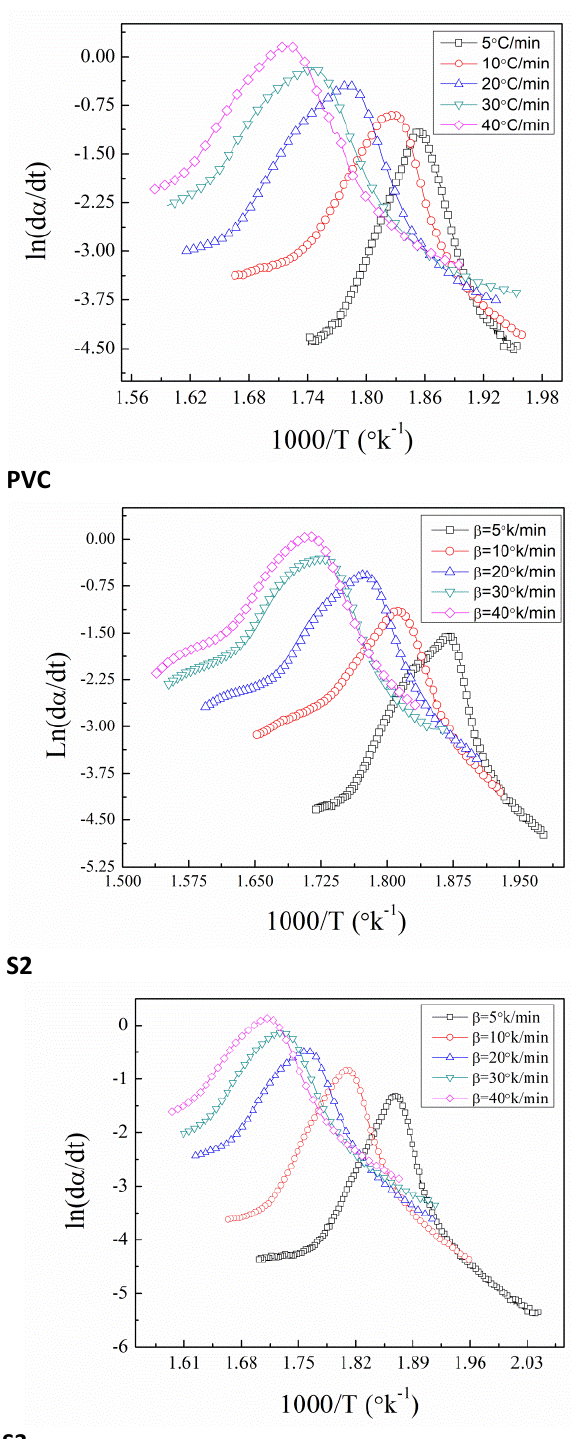
Figure 10: Variation of ln(d α /dt) with 1000/T during first decomposi- tion stage for pure PVC and PVC/MWCNTs nanocomposite samples at different heating